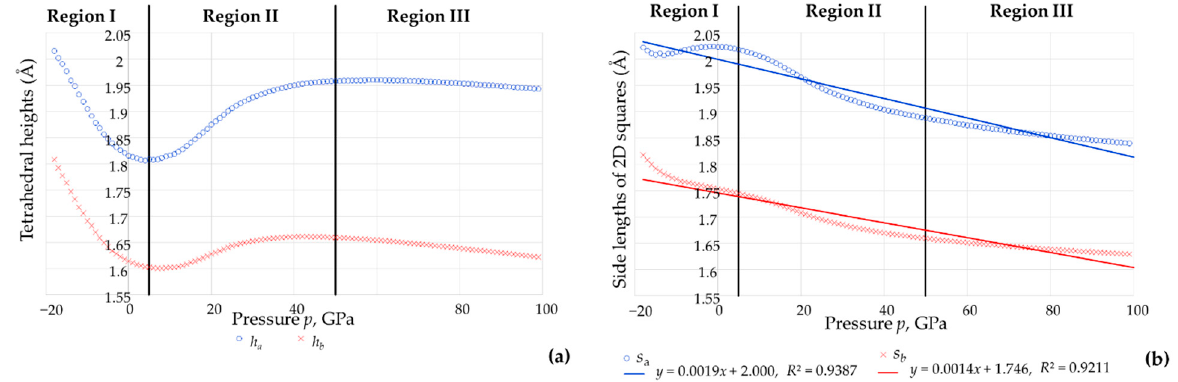
Figure 9. The relationships with pressure p of ( a ) the tetrahedral heights for the AsO 4 and BO 4 , h a and h b and ( b ) the length of the projected squares in the (001) plane, s a and s b . Figure 8. A plot of the sum of the six O-As-O intra-tetrahedral angles or six O-B-O angles pertaining to a single tetrahedron where it is shown that, subject to very minor discrepancies, the sum of angles always sums up to a constant value of c .